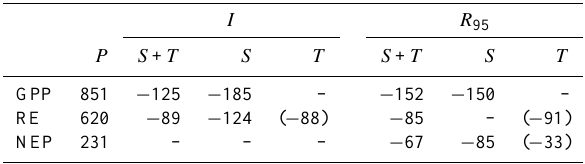
Table 7. Ecosystem flux effect sizes for total rainfall amount differ- ences ( P ) and differences in rainfall distribution measures (precip- itation intensity I and R 95 ), for combined spatio-temporal ( S + T ), spatial ( S ) and temporal ( T ) regressions. All effect sizes are mea- sured in gCm − 2 yr − 1 and regression-based values are for all sites together (for S + T and S ), using the regression slope and the appro- priate standard ecosystem flux standard deviation. Only effect sizes from regressions significant at the 5% level are shown, and val- ues in parentheses for the temporal regressions are indicative values from single